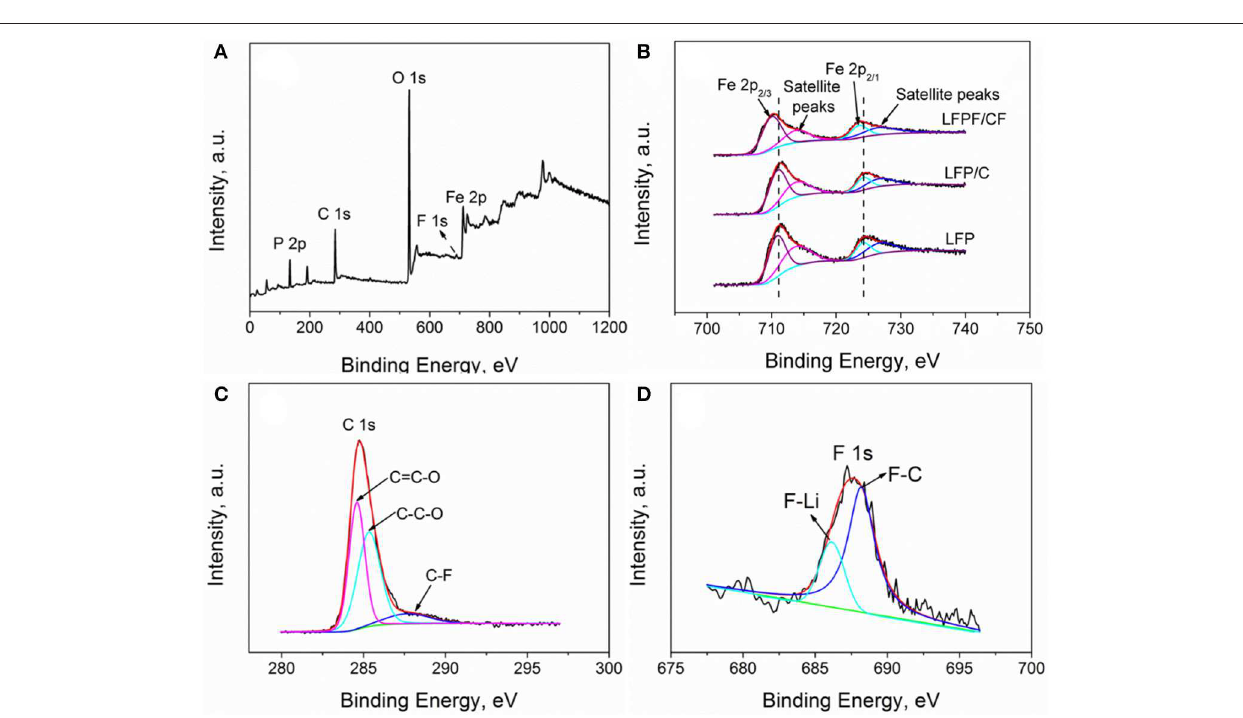
surface of LFP particles. Meanwhile, it is observed that the d-spacing of lattice fringes for LFP and LFP/C are almost 0.272 nm, corresponding to the (102) plane of the LFP. While, LFPF/CF composite show the d-spacing of lattice fringes of 0.274 nm, which is higher than that of LFP and LFP/C. Obviously, the interlayer spacing was enlarged with fluorine doping into LiFePO 4